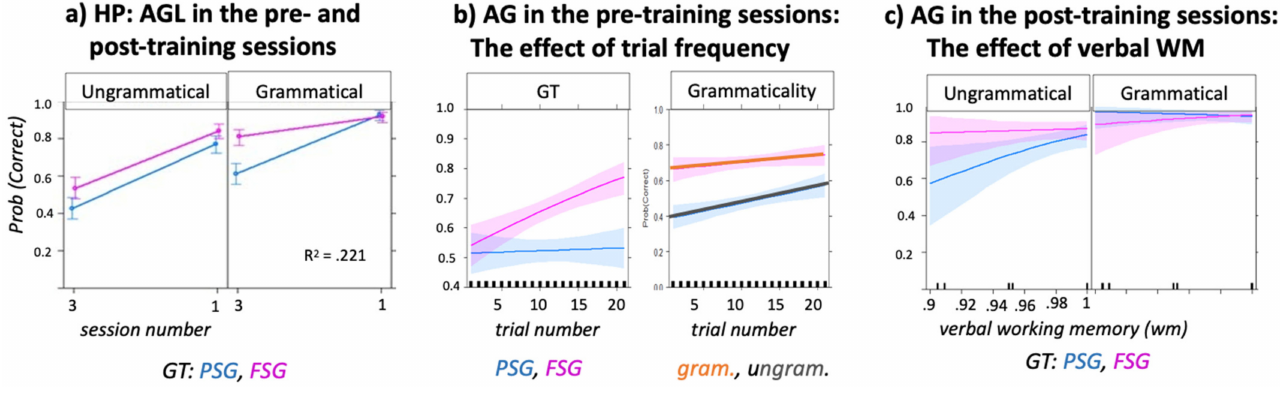
Figure 3. Artificial Grammar Learning (AGL) in ideal native speakers ( n = 37). ( a ) The figure displays the results of the significant Session × Grammaticality × Grammar Type (GT) interaction in the group of healthy participants (HP). For grammatical trials (gram), but not ungrammatical trials (ungram), HP showed higher accuracy on FSG than PSG items during the pre-training session (preference classification), whereas accuracy on FSG and PSG grammatical items was equally high in the post- training session (grammatical classification). ( b ) The two graphs illustrate the learning behavior exhibited by HP in the pre-training sessions: as they were exposed to more trials, their performance on FSG (but not PSG) trials improved. ( c ) Verbal working memory positively interacts with the identification of ungrammatical PSG (but not FSG)